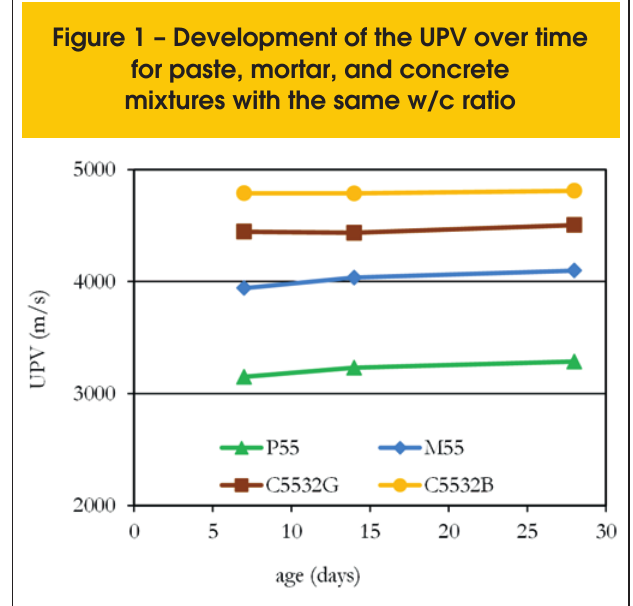
Table 2 – Ultrasonic pulse velocity Figure 1 – Development of the UPV over time